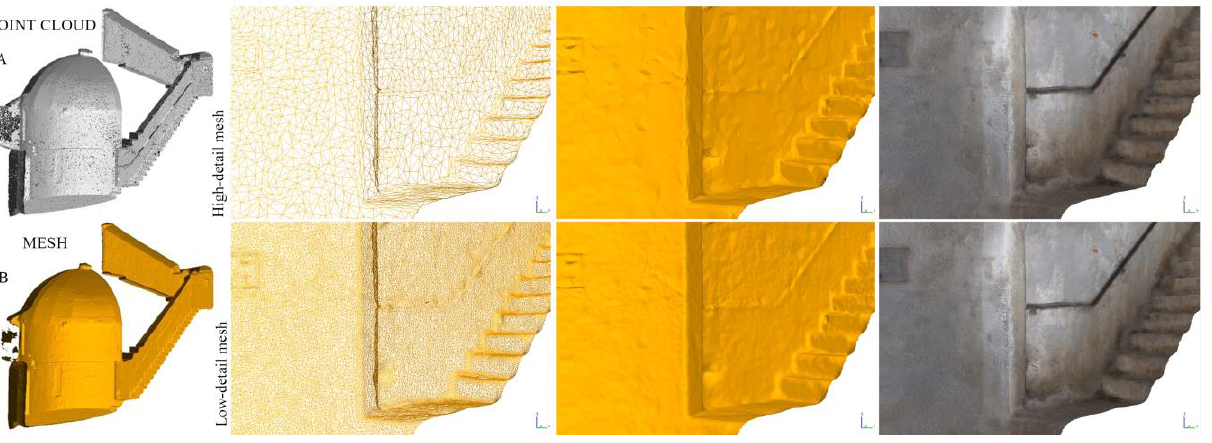
Figure 13. Sample of the point cloud A and mesh surface B after the import in the photogrammetric software interface.